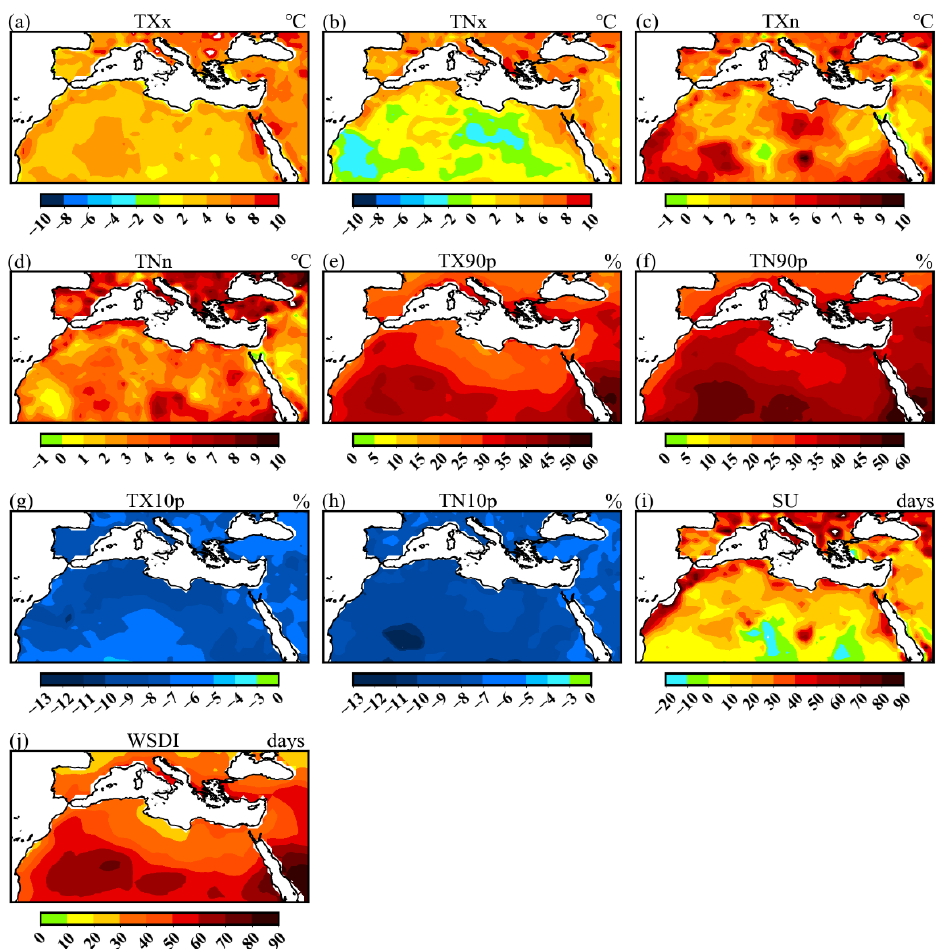
Figure 8. Projected changes in extreme temperature from multi-model ensemble mean CMIP6 GCMs bias-adjusted data during the mid-future (2041–2070) relative to the baseline period (1995–2014) for the SSP5-8.5 scenario. The indices reflect the intensity (TXx, TNx, TXn and TNn) ( a – d ), frequency (TX90p, TN90p, TX10p, and TN10p) ( e – h ) and duration (SU and WSDI) ( i , j ) of the extreme events.